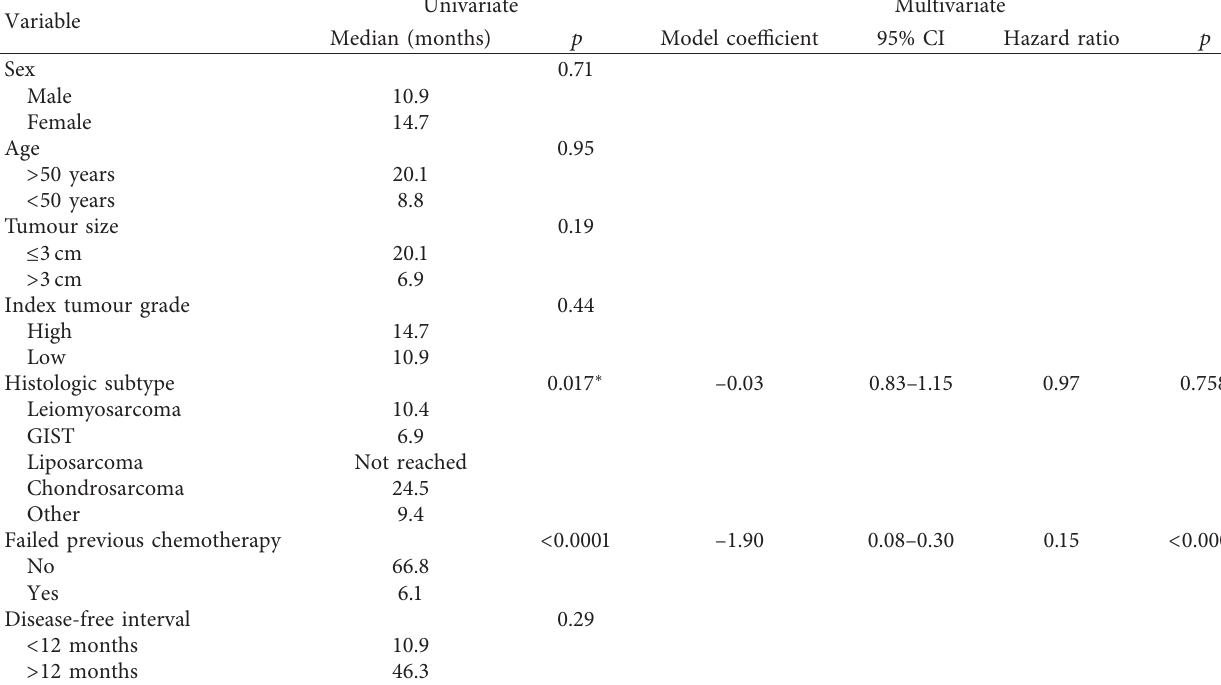
Table 3: Systemic chemotherapy-free interval in sarcoma patients undergoing